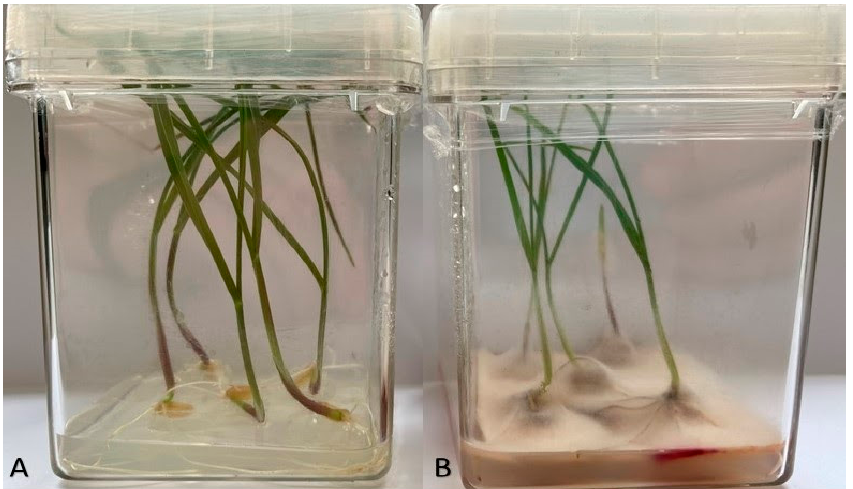
Figure 6 . Two-week old durum wheat seedlings growing in pathogen-free medium ( A ) and the medium infected with F. culmorum medium ( B ).